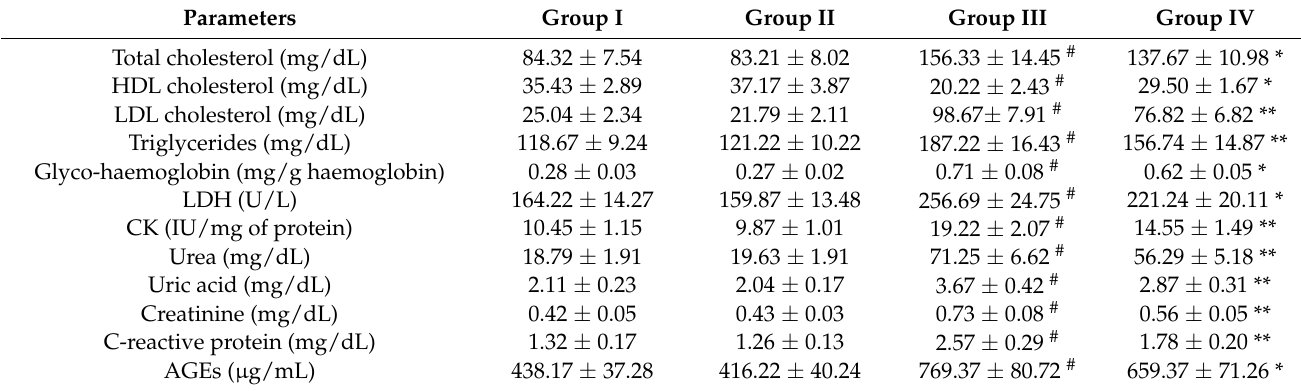
Table 1. Effects on serum biochemical parameters of experimental